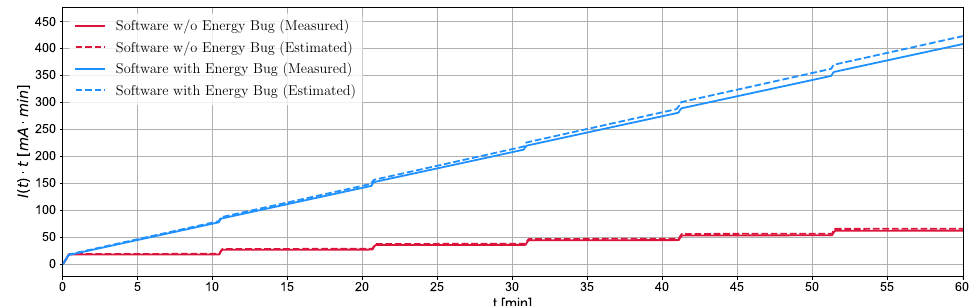
Figure 26. Comparison of an energy bug free software application with an application containing an energy bug where the RAK811 module stays in a higher power